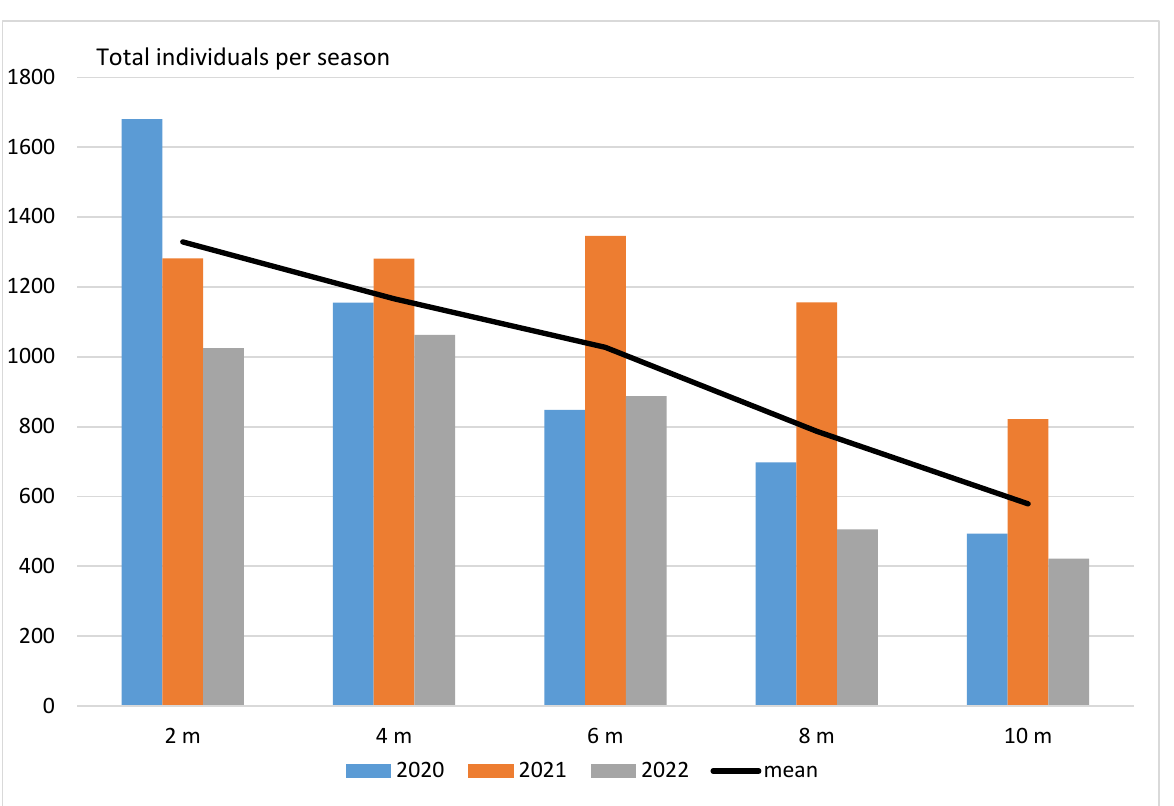
Figure 6. Cumulative Lepidoptera abundance at various heights in forest glades in 2020–2022.